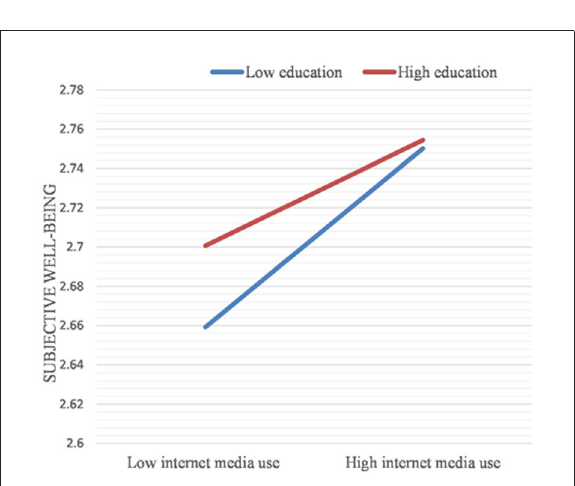
FIGURE4 Simple slope plot for the interaction between internet media use and education (Dependent variables: Subjective well-being).